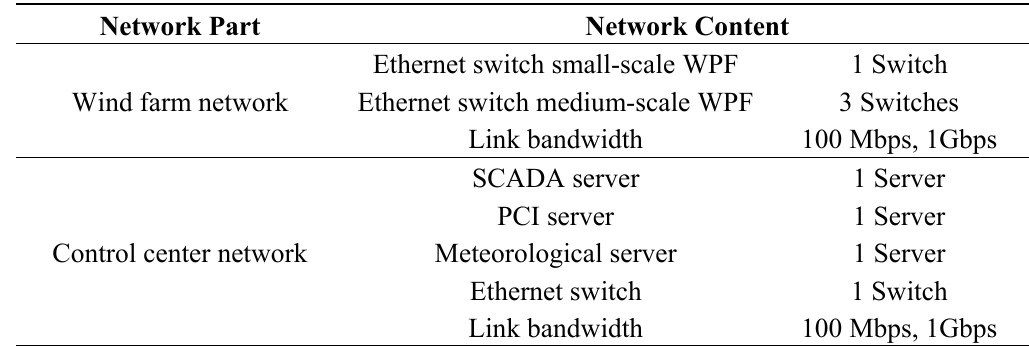
Table 8. Configuration of FAN and